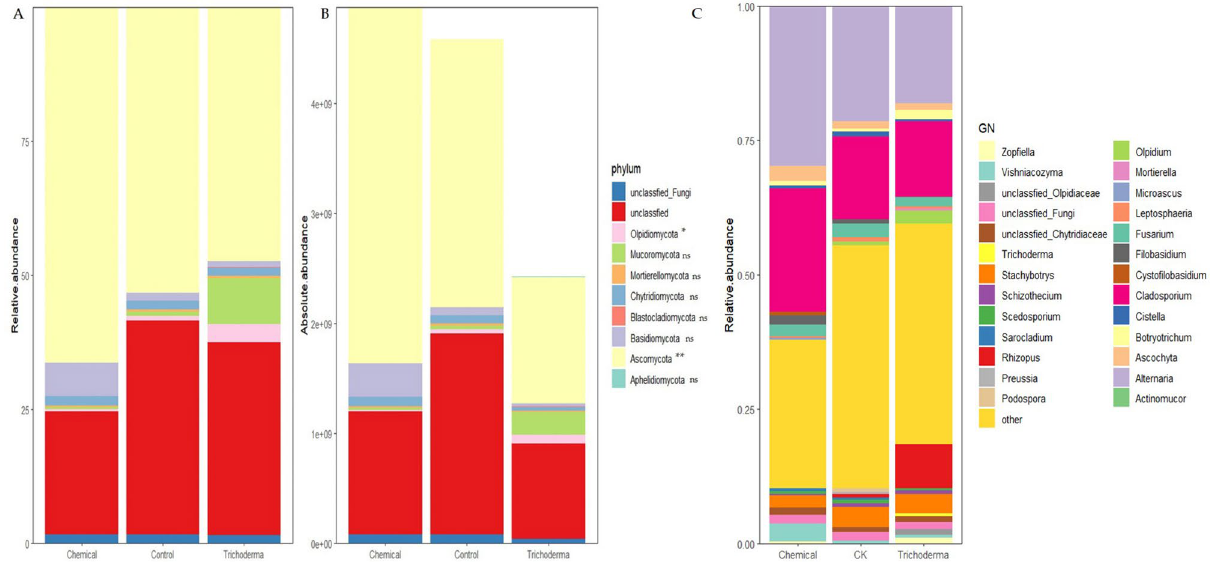
Figure 4. Rhizosphere fungal community structure at the phylum and genus level as affected by control seed dressing (Control), T. atroviride HB20111 seed dressing ( Trichoderma ), and chemical fungicide seed dressing (Chemical). Relative fungal abundance at the phylum level ( A ), absolute fungal abundance at the phylum level ( B ) and relative fungal abundance at the genus level ( C ). ns, not significant at p < 0.05; *Indicates significance at p < 0.05; **Indicates significance at p < 0.01 based on Games–Howell as the post hoc test and Benjamini– Hochberg FDR as the multiple test correction